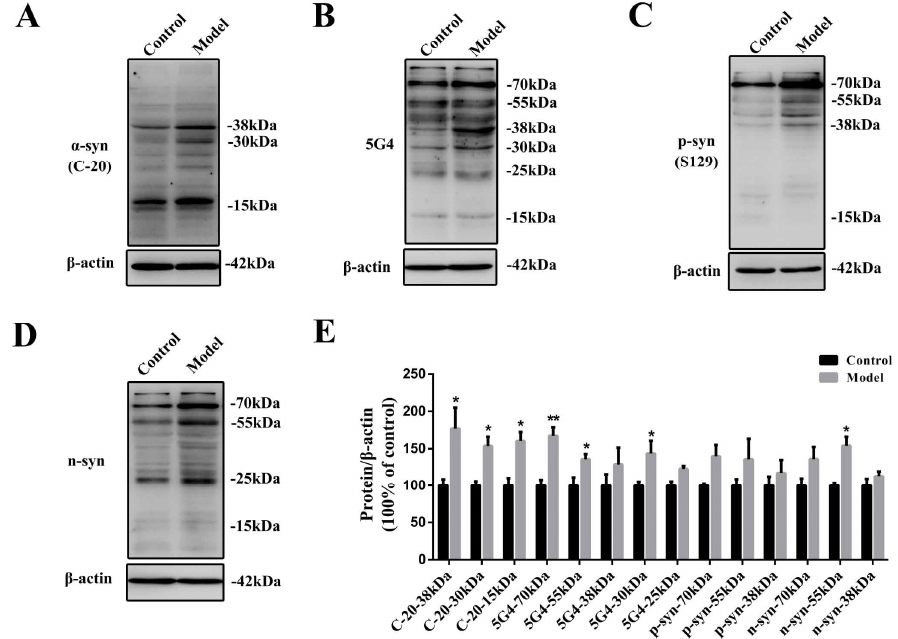
Figure 2. α -synuclein abnormalities in the chronic MPTP/p-induced PD mouse stomach detected by Western blotting. Representative protein bands detected using ( A ) anti- α -syn (C-20), ( B ) 5G4, ( C ) anti-p-syn (S129), ( D ) anti-n-syn and β -actin antibodies are shown. ( E ) A histogram representing the quantitative analysis of different forms of α -synuclein levels detected by anti- α -syn (C-20), 5G4, anti-p-syn (S129), and anti-n-syn antibodies normalized to β -actin protein levels is shown ( n = 4). The data are presented as the means ± SEM, * p < 0.05, ** p < 0.01 compared with the control group. PTMs are also disease-related and aggregation-contributed [30]. α -synuclein phos- phorylated at Ser129 (p-syn [S129]), and nitrated α -synuclein (n-syn) were also detected in the stomach. All of the phosphorylated and nitrated forms of α -synuclein in the